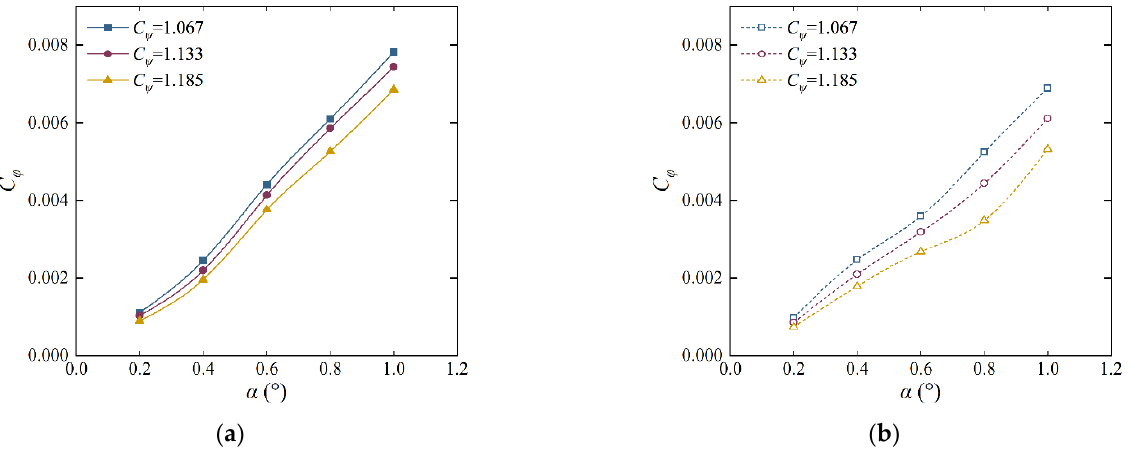
Figure 10. Flow rate coefficient in pump mode with respect to GV opening angle under conditions of different head coefficients. ( a ) GV-O; ( b ) GV-M.